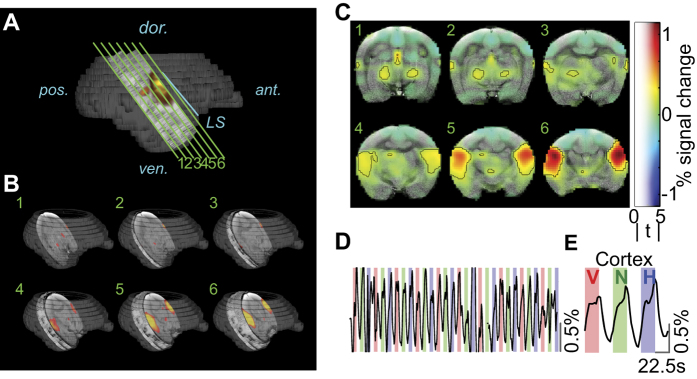
BOLD activity in the auditory cortex.(A) Six slices (green lines) of 1.2 mm thickness were positioned parallel to the lateral sulcus (LS; blue line), with the last slice abutting the LS. Dark gray structure is a surface reconstruction of Subject C’s brain from an anatomical scan, light gray region corresponds to the indexed location of functional slices, and heatmap corresponds to regions of significant BOLD activation (t ≥ 5). (B) Three dimensional view showing slice positioning relative to the whole brain, and regions of significant BOLD activation (heatmap). (C) Average predictor value (beta) for the three vocalization stimuli mapped on to an anatomical MRI (left side of figure is left hemisphere). Here the heat map corresponds to the percent change in BOLD activation, transparency corresponds to the t-statistic, and black contours encompass regions with a t-statistic greater than five (corresponds to FDR-corrected q value < 10−5). (D) Average time-course from all voxels with t > 5, across 10 repetitions of the three vocalization stimuli – conspecific vocalizations (V; red shading), phase-scrambled vocalizations (N; green shading) and heterospecific vocalizations (H; blue shading). (E) Time-course data in (D) averaged over all 10 repetitions for significant cortical voxels (t > 5).